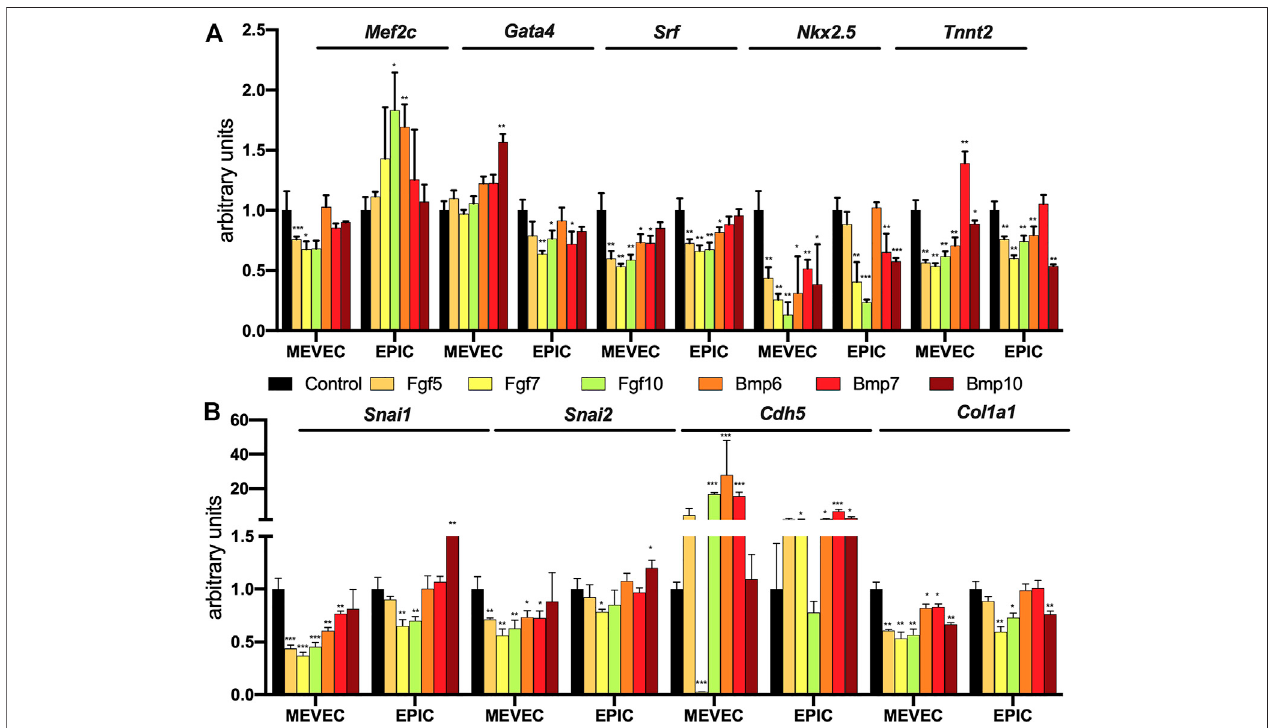
FIGURE 11 | Panel (A) RT-qPCR analyses of Mef2c, Nkx2.5, Srf, Gata4 and Tnnt2 expression after control, Bmp6, Bmp7, Bmp10, Fgf5, Fgf7 and Fgf10 treatmentsinMEVEC(endocardial)andEPIC(epicardial)celllines,respectively.Panel (B) RT-qPCRanalysesofSnai1,Snai2,Cdh5andCol1a1expressionaftercontrol, Bmp6, Bmp7, Bmp10, Fgf5, Fgf7 and Fgf10 treatments in MEVEC (endocardial) and EPIC (epicardial) cell lines, respectively. * p < 0.05, ** p < 0.01, *** p < 0.001, **** p < 0.0001.